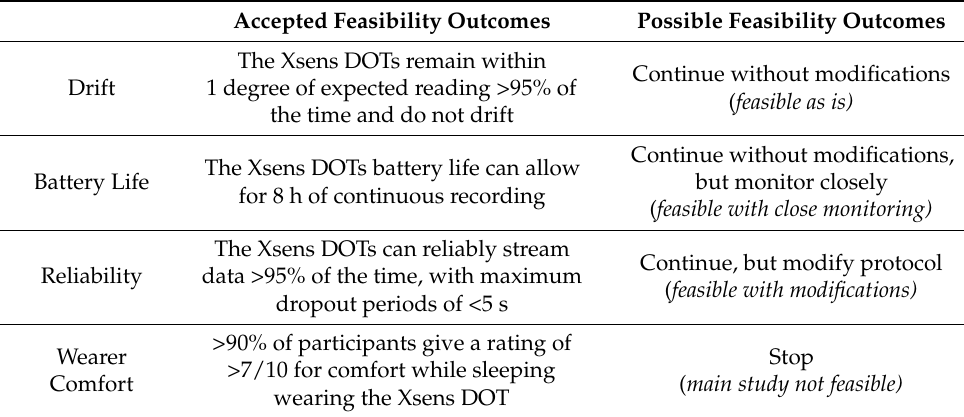
Table 1. Feasibility criteria according to Thabane et al [25].